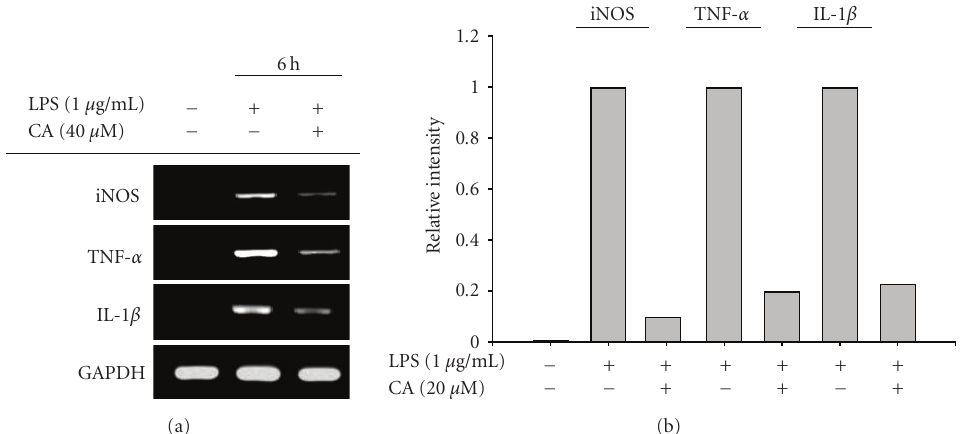
Figure 3: E ff ect of CA on mRNA levels of inflammatory genes in LPS-activated RAW264.7 cells. (a and b) RAW264.7 cells (5 × 10 6 cells/ml) were incubated with CA in the presence of LPS (1 μ g/ml) for 6h. (a) The mRNA levels of TNF- α , iNOS, IL-1 β , and GAPDH were determined by RT-PCR. (b) Relative intensity was determined by densitometric scanning.